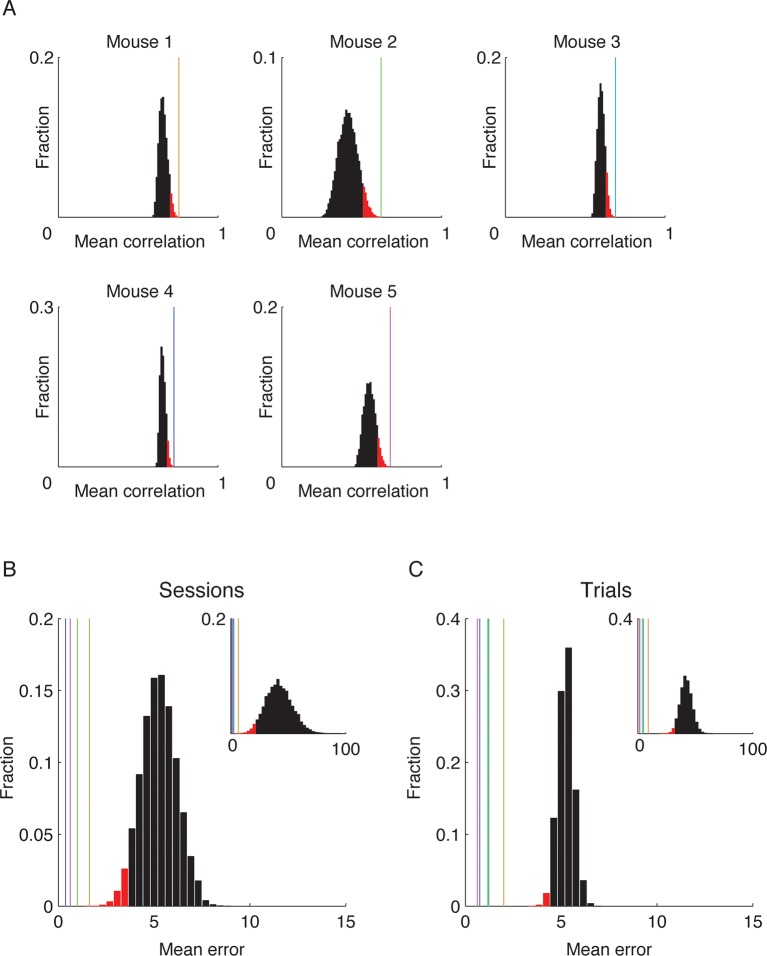
Time decoders accurately expose temporal information in all individual mice.(A) Distributions of the correlations between ensemble activity patterns averaged over the seven pairs of neighboring days for all 8!/2 possible day permutations (the top 5% of the correlations values are colored red). Colored vertical lines indicate the mean correlations between activity patterns of pairs of neighboring days (taken from both environments together) from the actual data. In all mice, the actual data yielded the highest mean correlation of all possible permutations. Therefore, maximizing the mean correlation between pairs of days allows for an accurate ordering of the data from different days of the experiment (p < 5 · 10−5 for each mouse). (B,C) Performance of across environment time decoder on whole sessions (B) and single trials (C) exceeded the chance level in all mice. (B) Distribution of mean errors over all 16 sessions for random day labeling of each session (n = 100,000). The top 5% of the performances are colored red and represent a significantly small mean error. Colored vertical lines represent the mean error for each mouse (color code as in A; p < 5 · 10−5). Inset, distribution of mean squared error (MSE) of chance levels and individual mouse performances (vertical lines). (C) Distribution of mean errors over all 80 trials for random day labeling of each trial (n = 100,000). The top 5% of the performances are colored red and represent a significantly small error. Colored vertical lines represent the mean error for each mouse (color code as in A; p < 5 · 10−5 for each mouse). Inset, distribution of mean squared error (MSE) of chance levels and individual mouse performances (vertical lines).